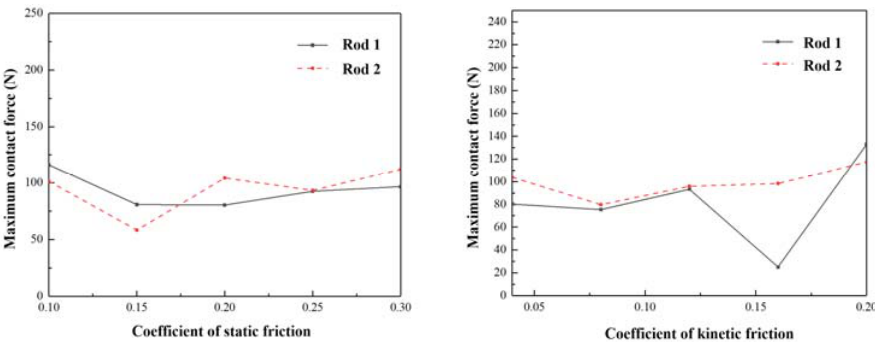
Figure 12. Effect of different friction coefficients on the maximum contact force in the initial guidance zone.